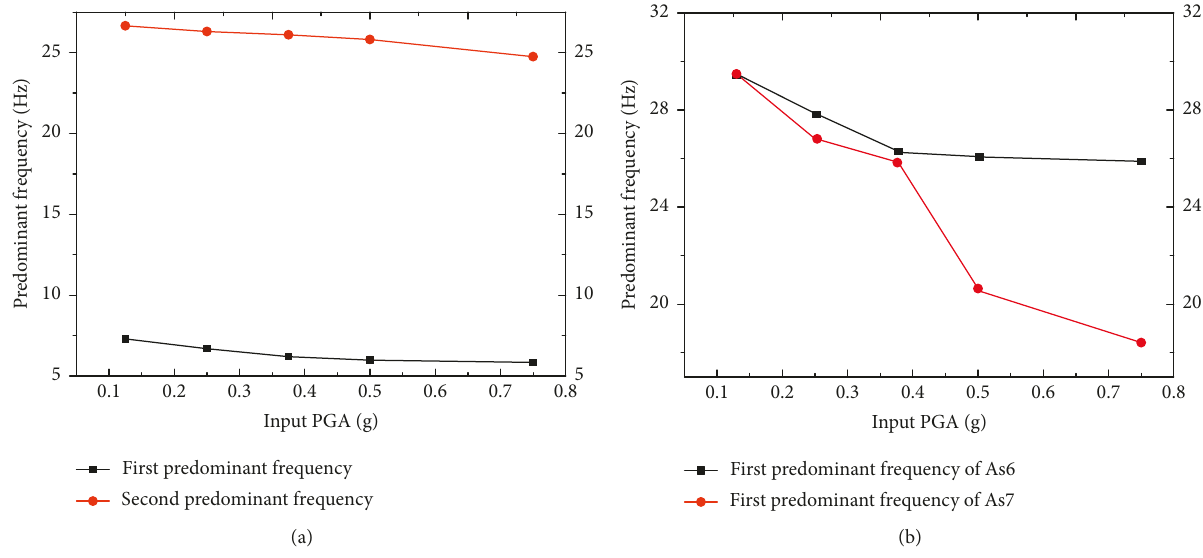
Figure 14: Evolution of predominant frequencies of the utility tunnel (a) and pipelines inside